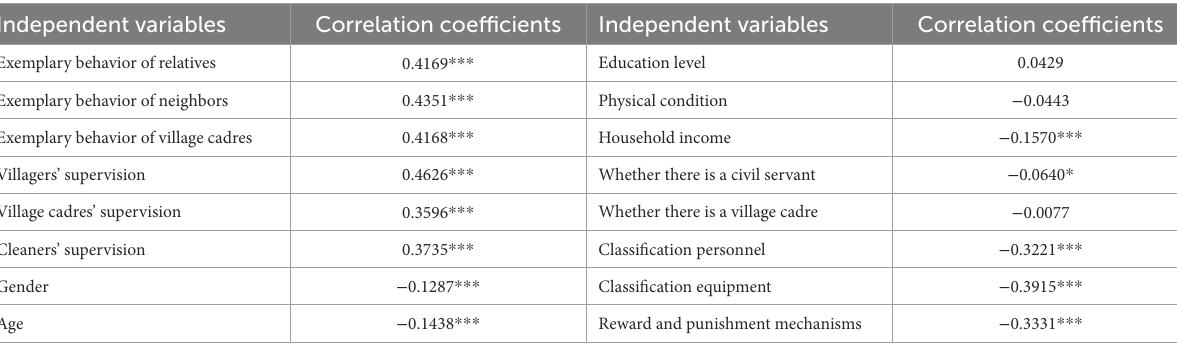
TABLE 4 Statistical table of Pearson correlation coefficient between key explanatory variables and control variables in farmer waste